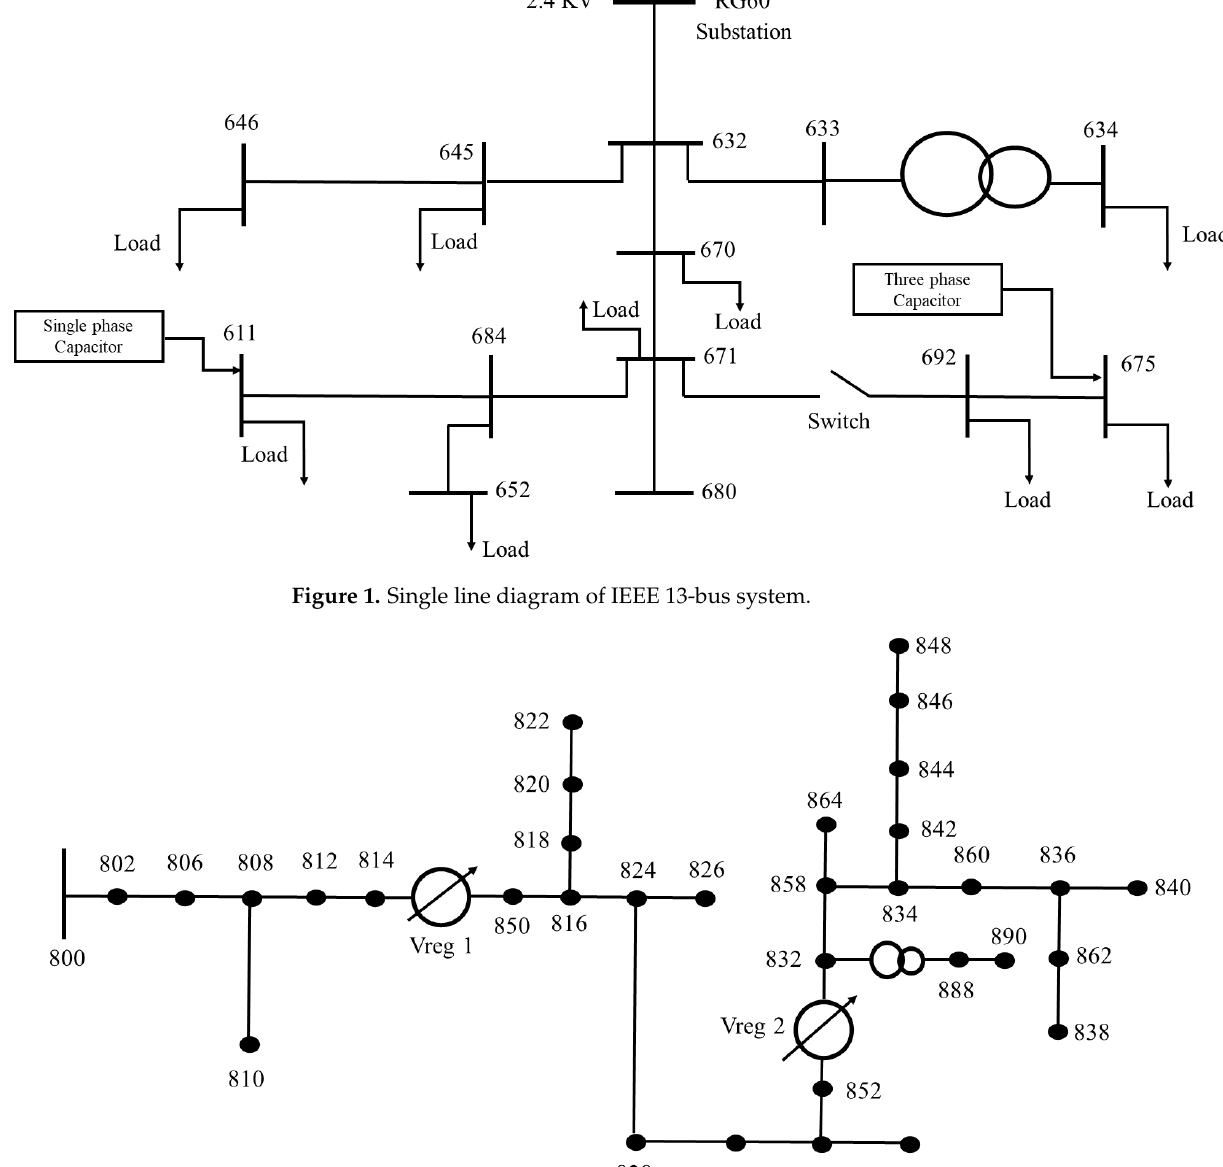
Figure 2. Single line diagram of IEEE 34-bus system.